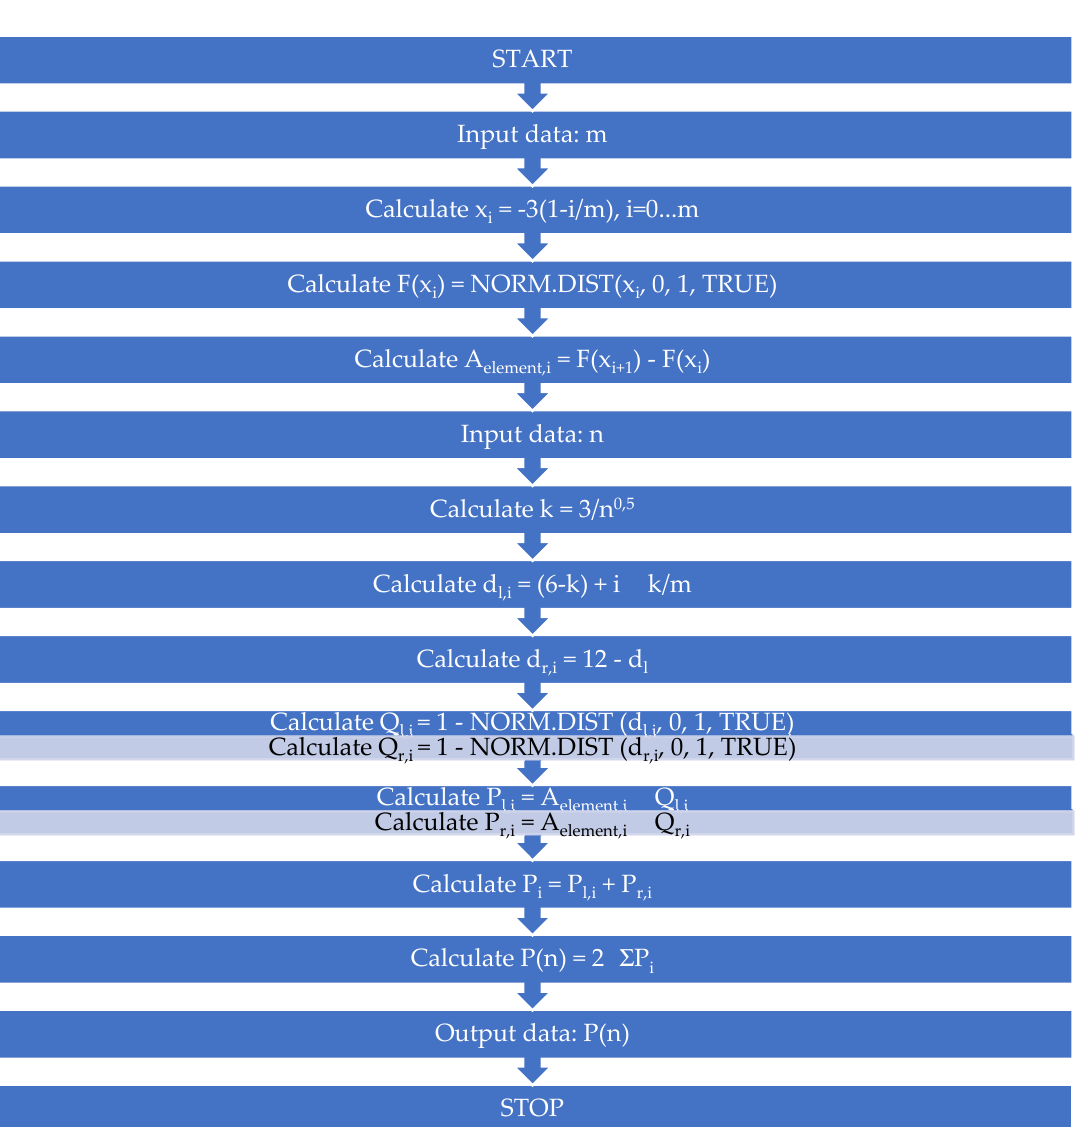
Table 1. The values for parts per billion, for n = 2 ... 10, obtained for different work steps.